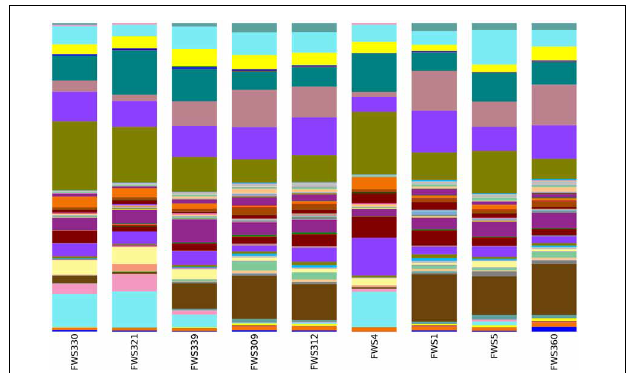
FIGURE 2 | Bacterial and archaeal community relative abundances of the major bacterial classes in soils derived from the sampling